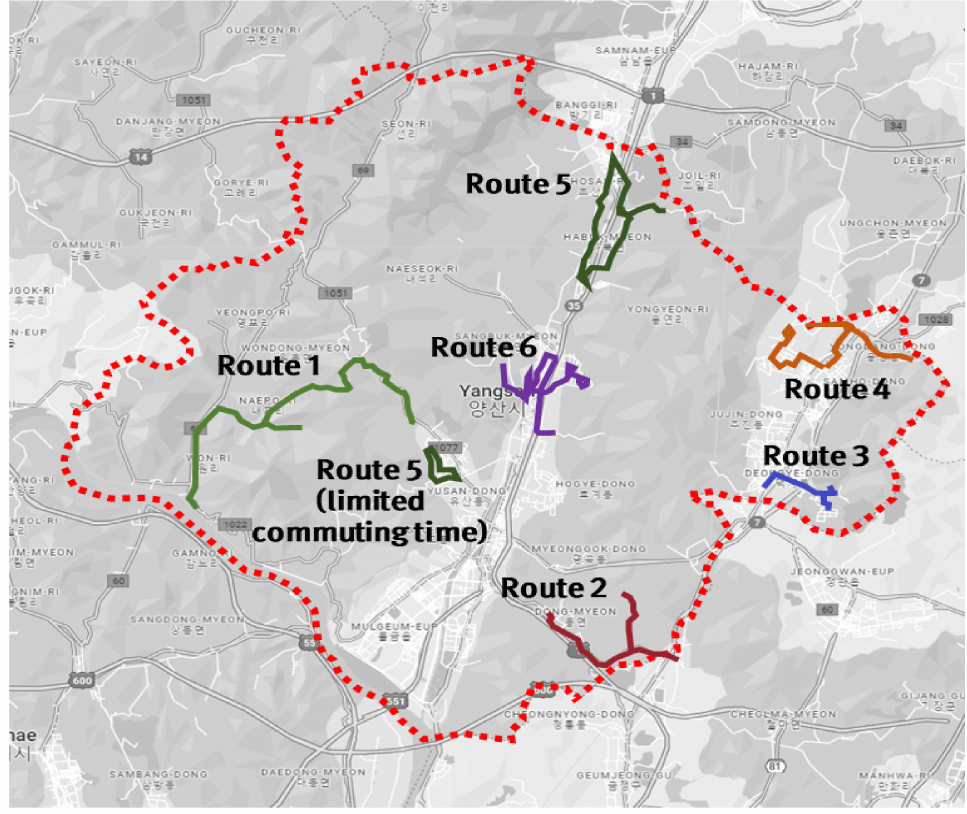
Figure 8. The distribution of the city-type bus routes in Yangsan-si. Table 1. City-type bus’s operation methods and features by the route in Yangsan-si. Route